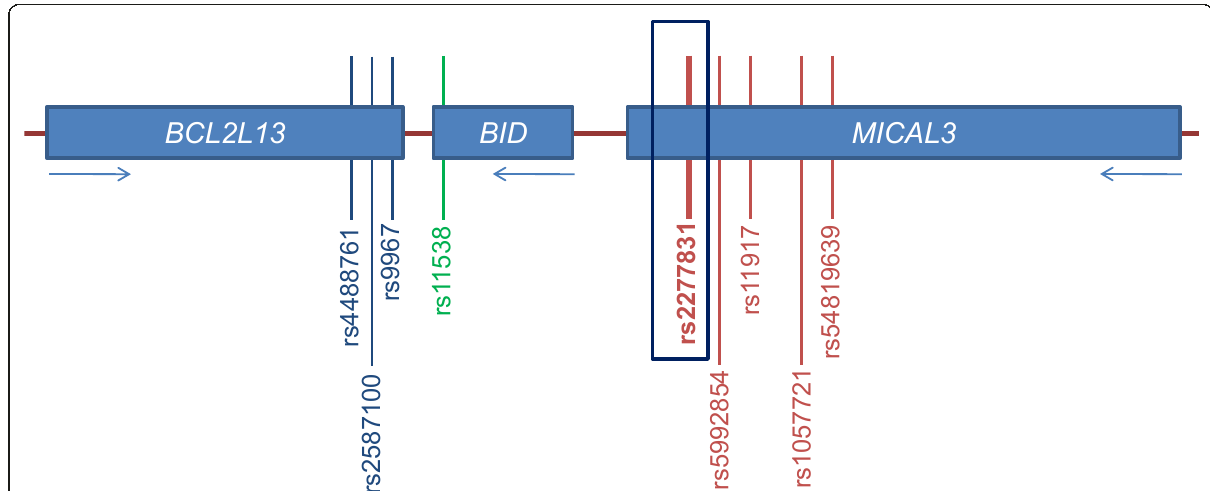
disequilibrium relative to the OA associated SNP